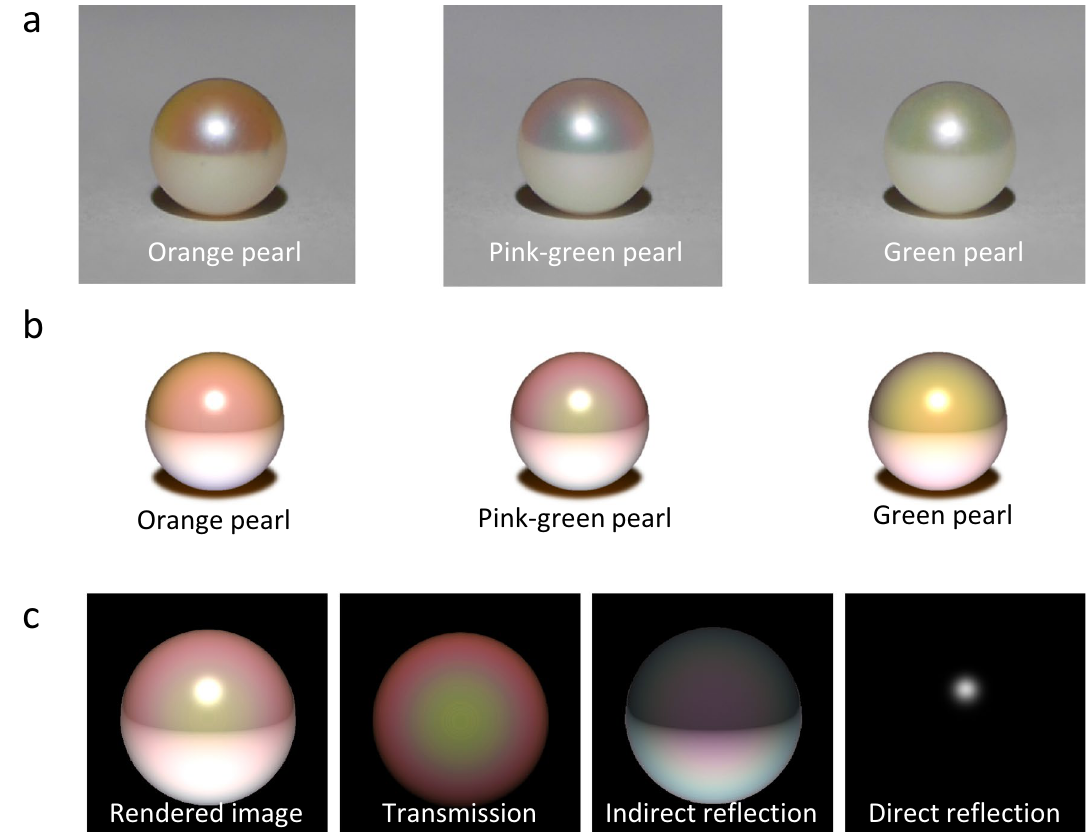
Figure 5. Real pearls and rendered images. ( a ) Photographs of three pearls of different colors. ( b ) Rendered images of pearls obtained using proposed optical model. ( c ) Transmission, indirect reflection, and direct reflection components of rendered image of pink-green